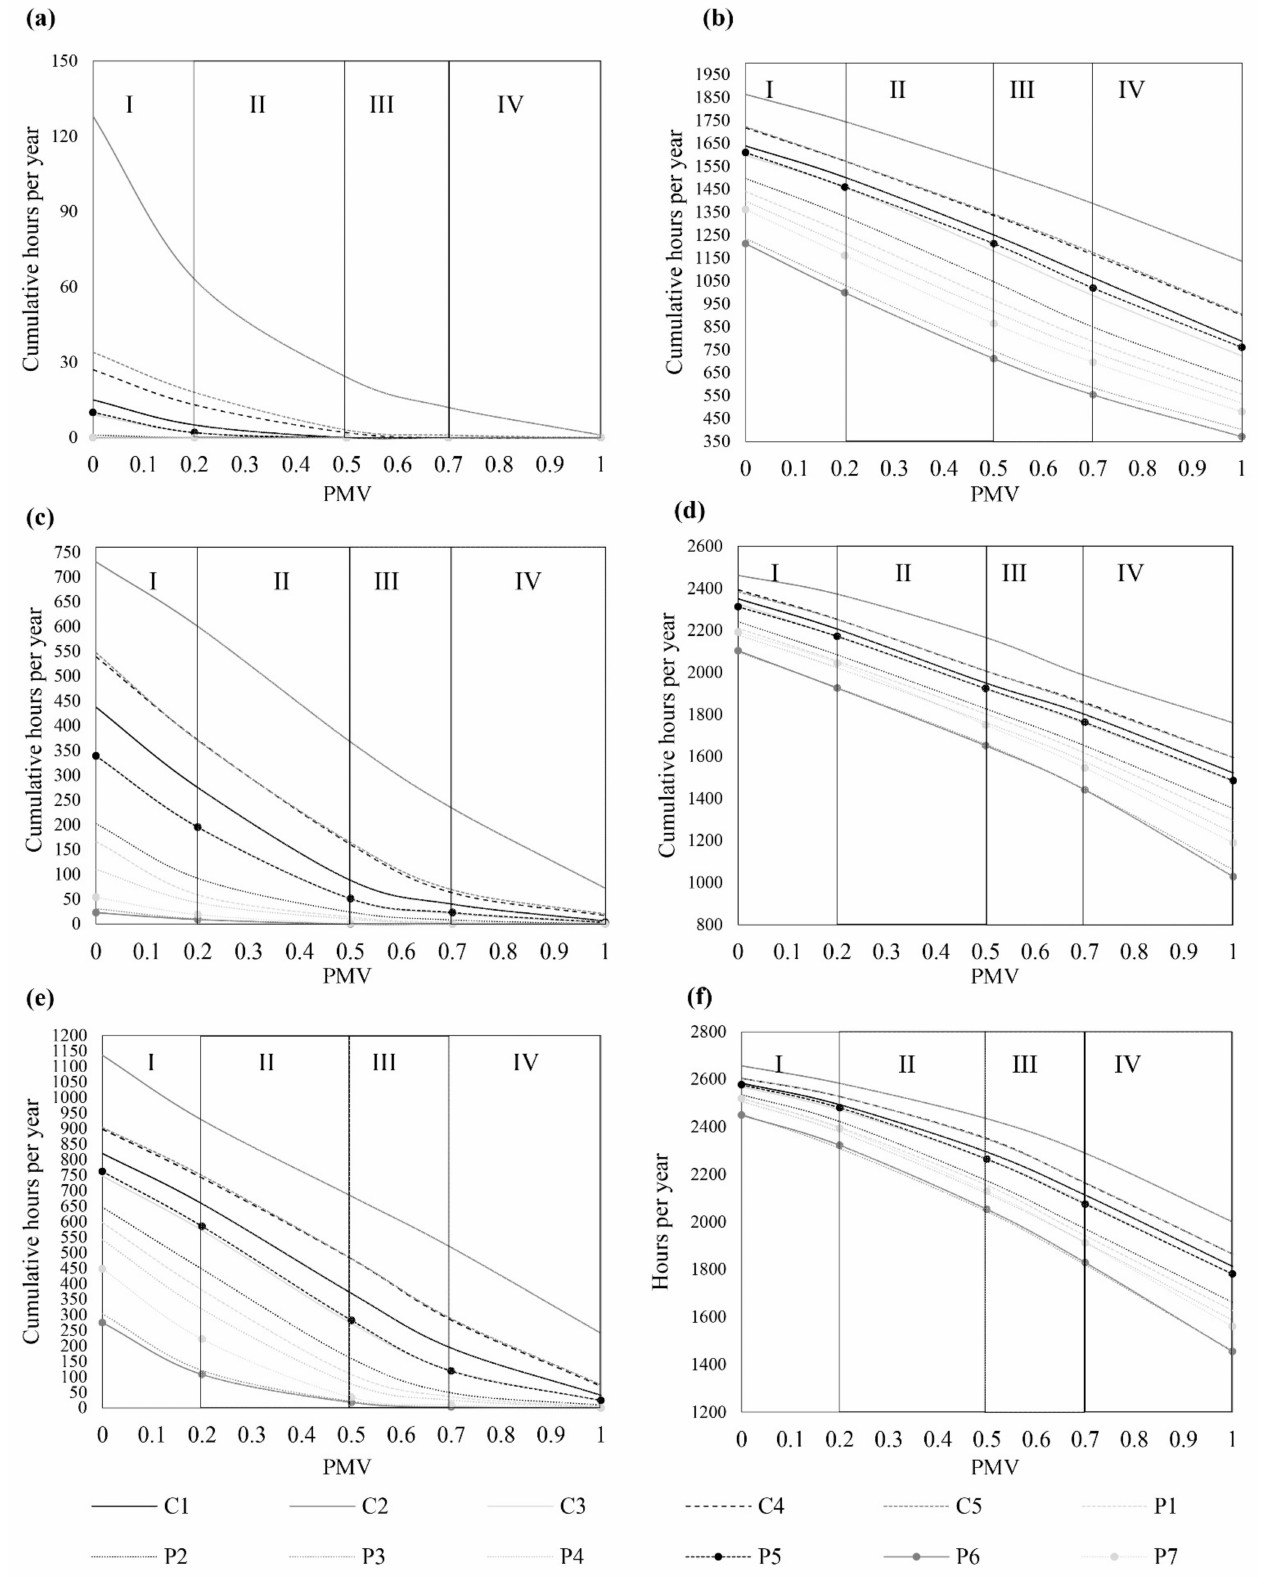
Figure 9. Cumulative hours per year for certain thermal comfort categories (PMV): 0.8 met, metabolic activity in Monfero ( a ) and Turin ( b ); 1 met in Monfero ( c ) and Turin ( d ); 1.2 met in Monfero ( e ) and Turin ( f